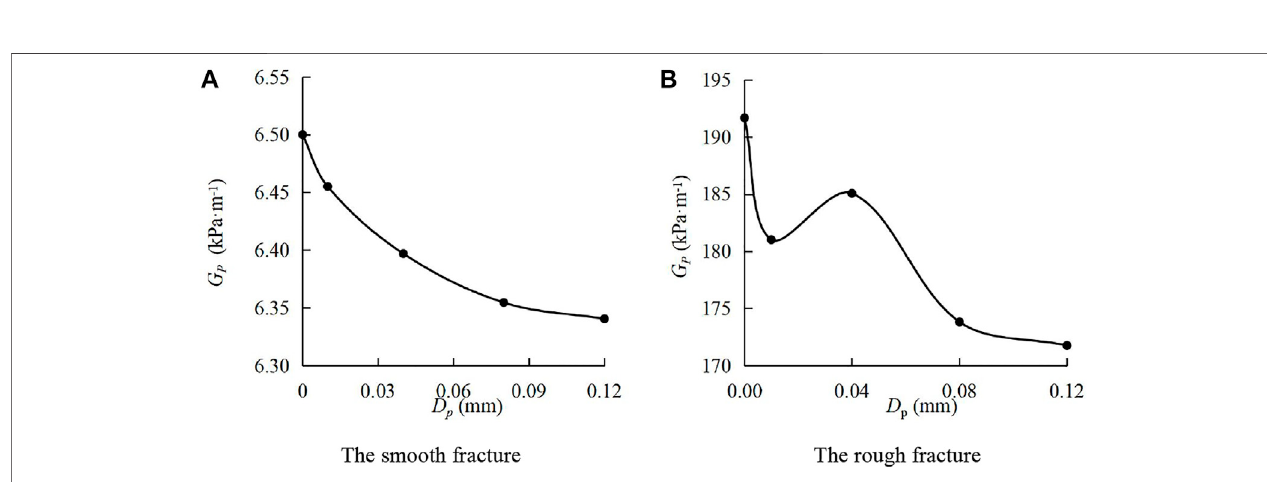
FIGURE 5 | Absolute value of the pressure gradient – sediment particle size curves. (A) Smooth fracture; (B) rough fracture.